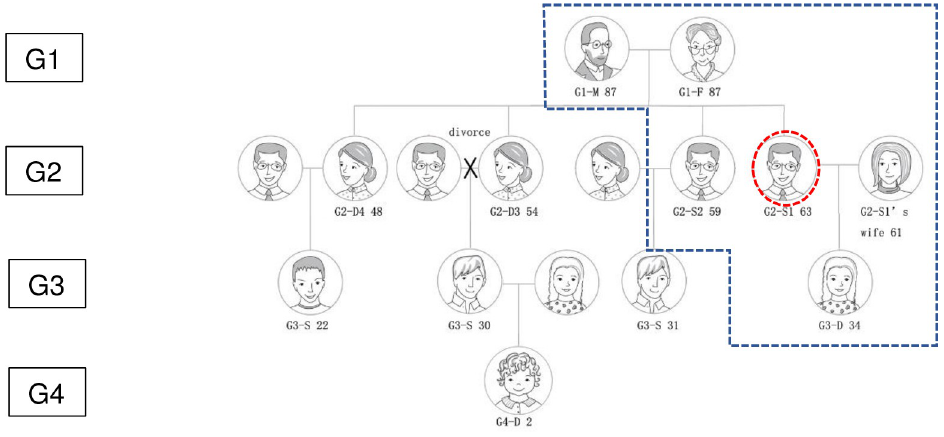
Fig 1. The Wang family